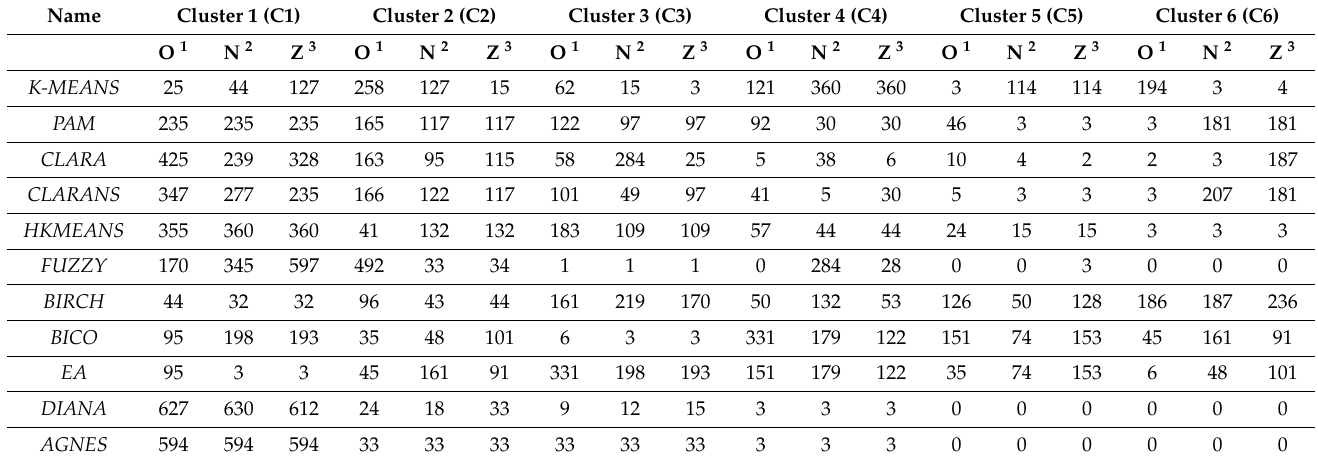
Table 3. Distribution of the number of cases according to the data set and the type of grouping.